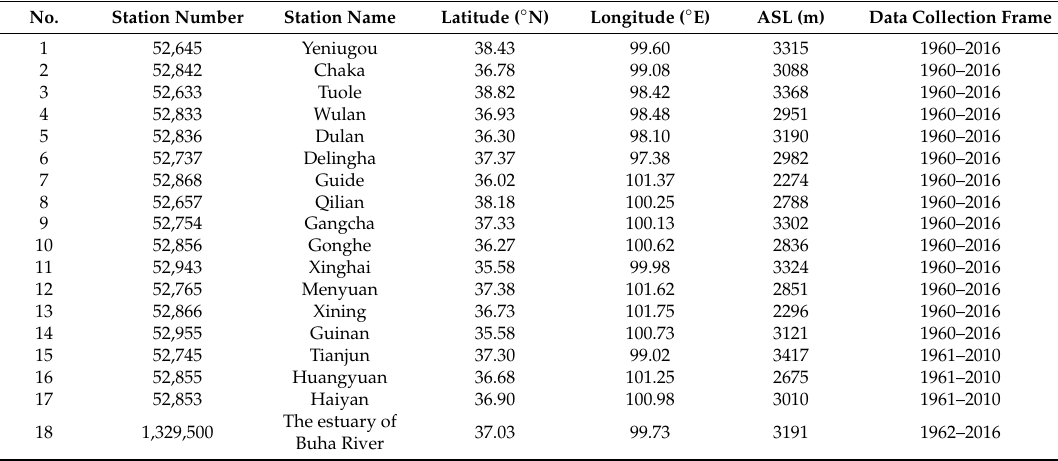
Table 1. Detailed information of the meteorological stations in and around Qinghai Lake basin used to collect the datasets previously